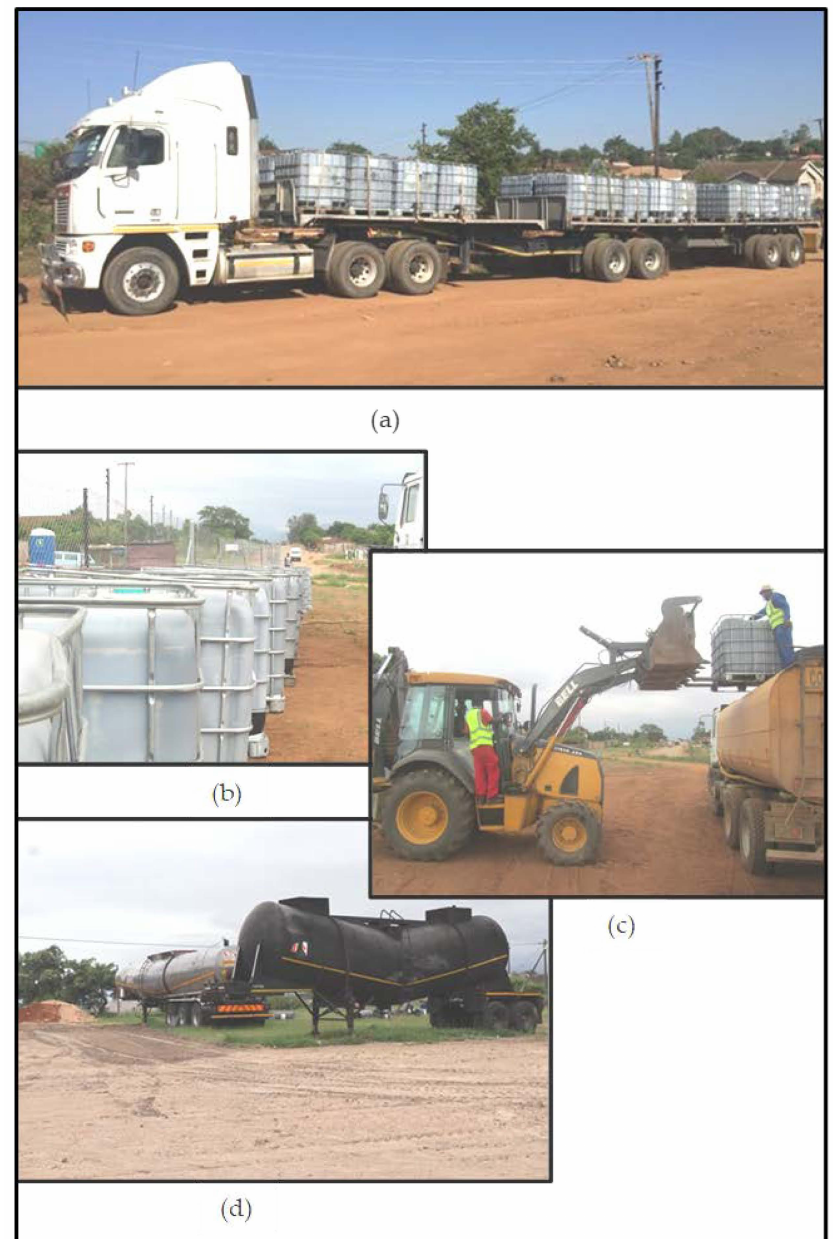
Figure 5. ( a ) Arriving on site of material-compatible anionic NME stabilising agents in 1000 L flow- bins. ( b ) Flow-bins containing a high-quality anionic NME stabilising agent exposed to high daily temperature. ( c ) NME stabilising agent delivered to construction water in water-bowser by lifting the flow-bit above the water-bowser and using gravity. ( d ) NME stabilising agent delivered to site in bulk